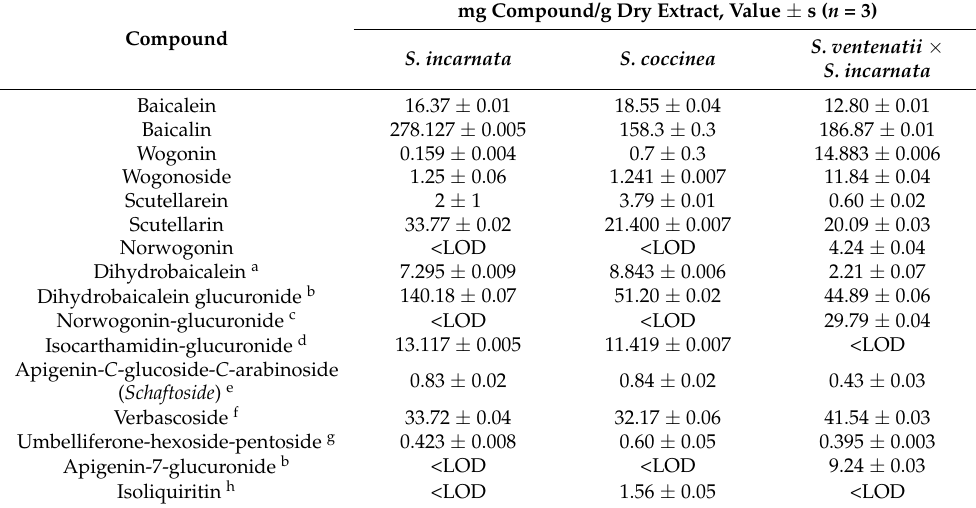
Table 4. Amounts (mg/g) of phenolic compounds present in extracts obtained from three Scutellaria